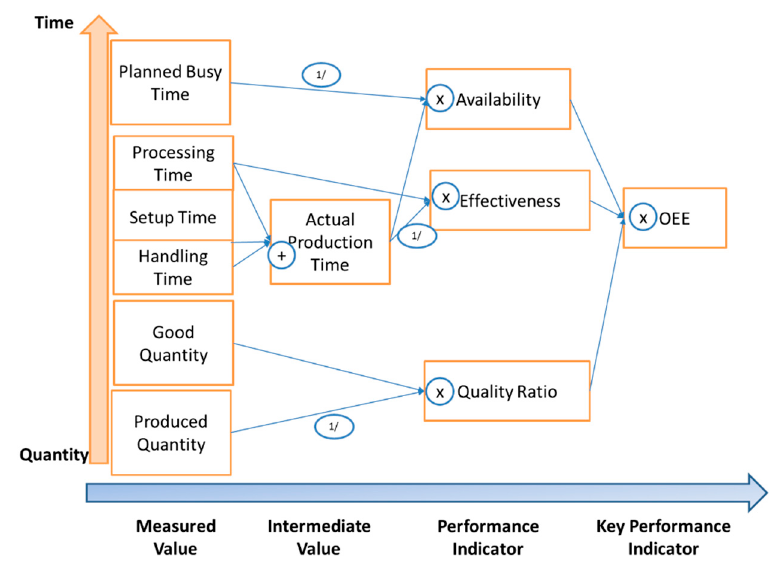
Figure 5. Relationship between Measured Values and KPI. Operations include summation, products and inversion.